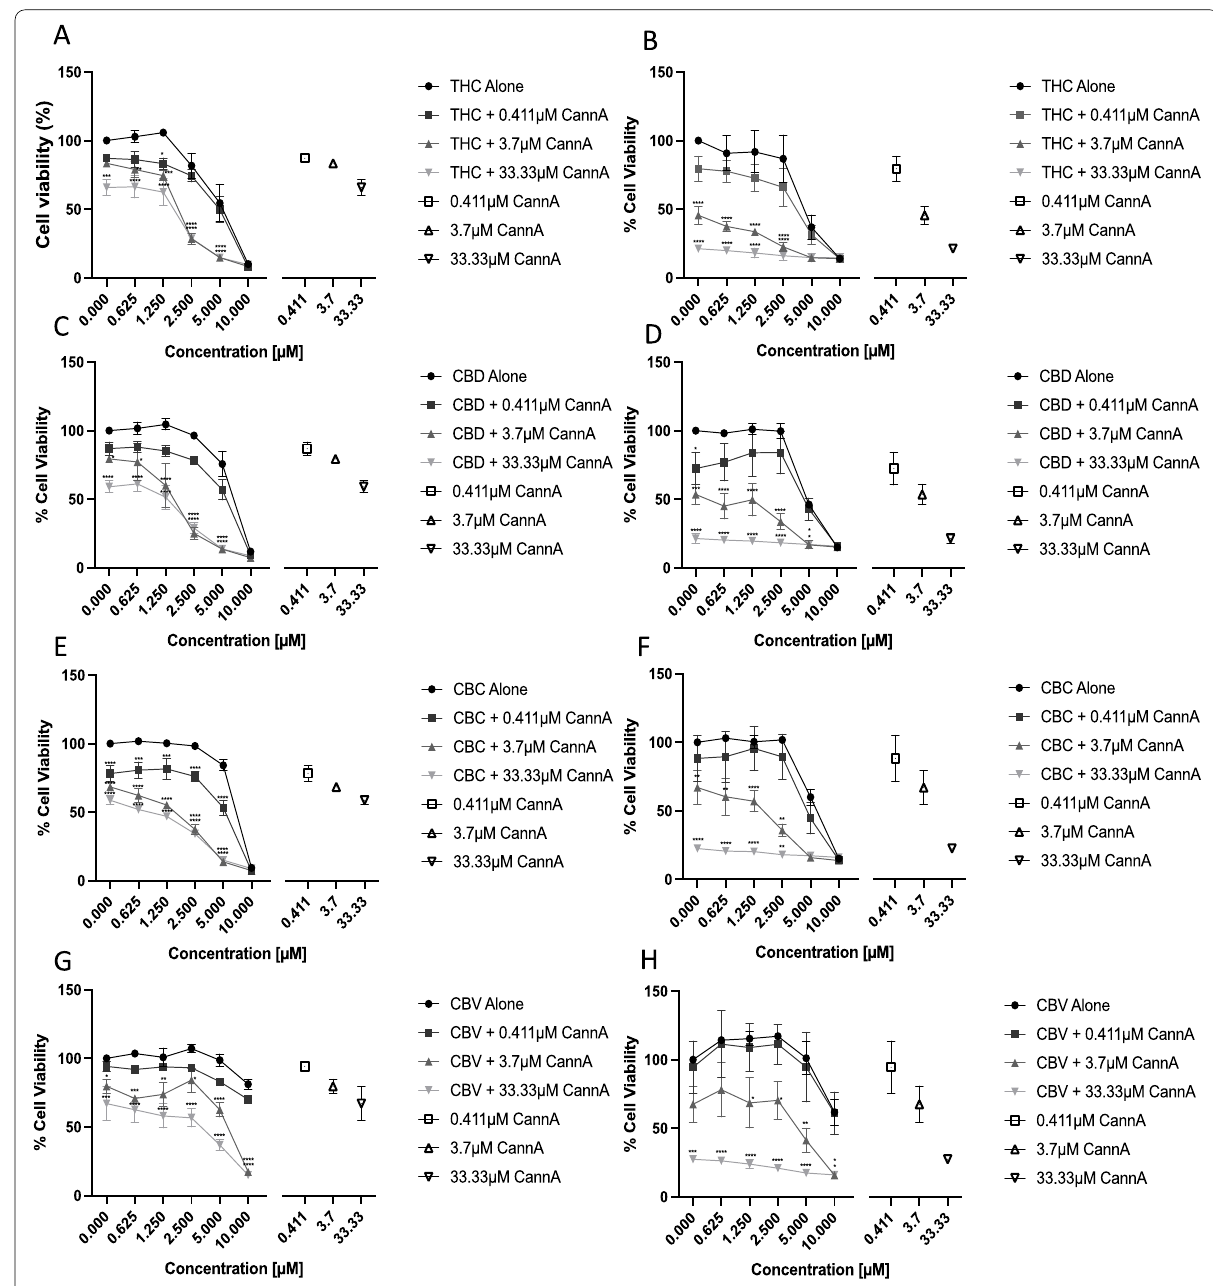
Fig. 6 Assessment of synergy between cannflavin A and cannabinoids. Cell viability of T24 ( A , C , E , G ) and TCCSUP ( B , D , F , H ) cells following treatment with Δ9-tetrahydrocannabinol ( A and B ), cannabidiol ( C and D ), cannabichromene ( E and F ), or cannabivarin ( G and H ) combined with 0.411, 3.7, or 33.33 μM cannflavin A. The statistics indicate the significance of the addition of the various concentrations of cannflavin A compared to treatment with cannabinoids alone. In each graph, the effect of cannflavin A at 0.411, 3.7, or 33.33 μM cannflavin A is indicated by open data points (on the right of the graph). Results represent the means SEM of 3 experiments. * p <0.05, ** p <0.01, *** p <0.001, **** p <0.0001. Combinations with ± 3.7 and 33.33 μM cannflavin A were deemed most statistically